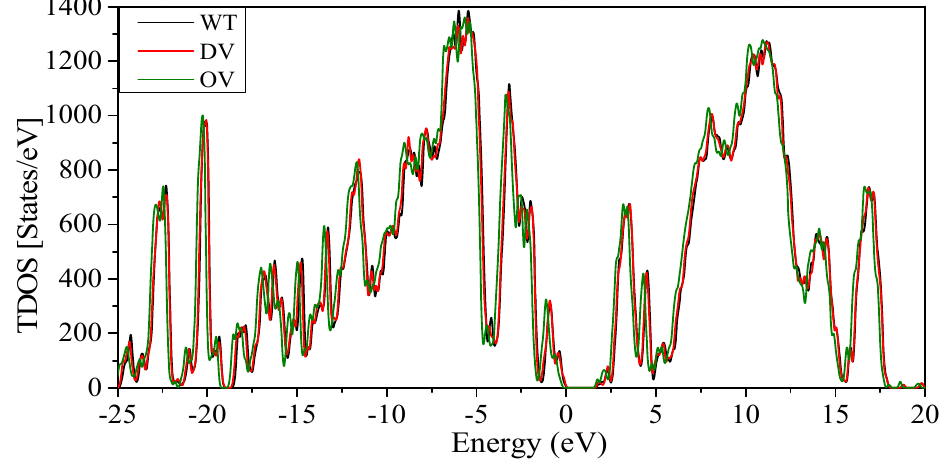
Figure 3. Total density of states (TDOS) for the RDB-SD1 model in WT, DV, and OV. HOMO-LUMO gap is 1.68 eV.